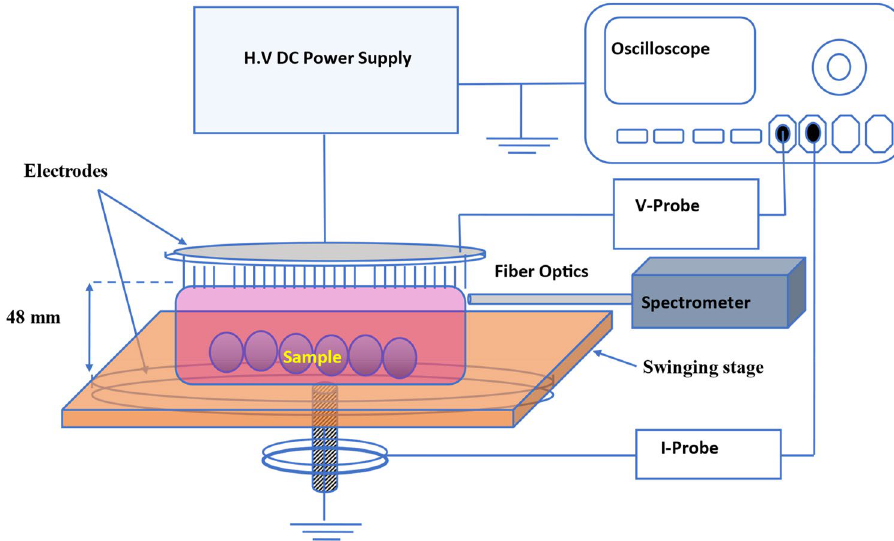
Figure 7. Large volume atmospheric pressure air plasma experimental setup